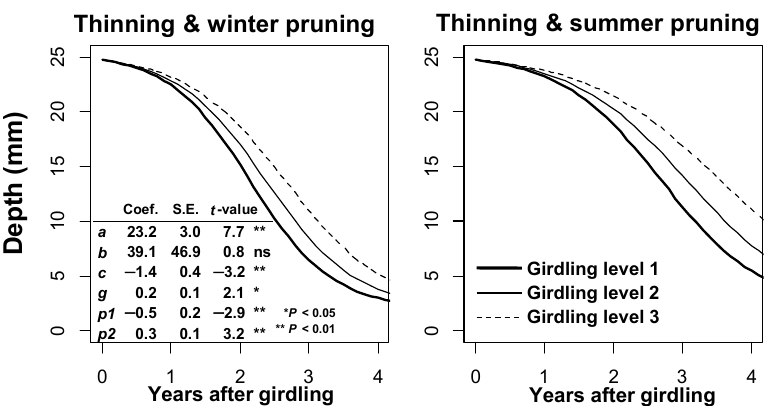
Figure 4. Dependence of remaining girdling depths on time after girdling manipulation across dif-